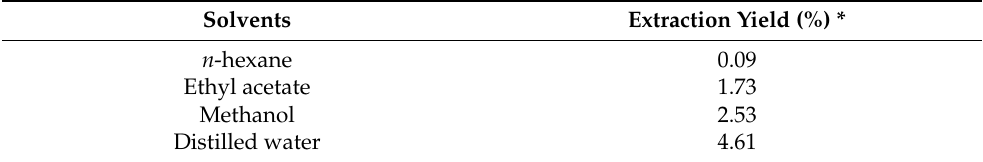
Table 3. Extraction yields of different solvents from the fungus combs from the M. gilvus Mounds. Solvents